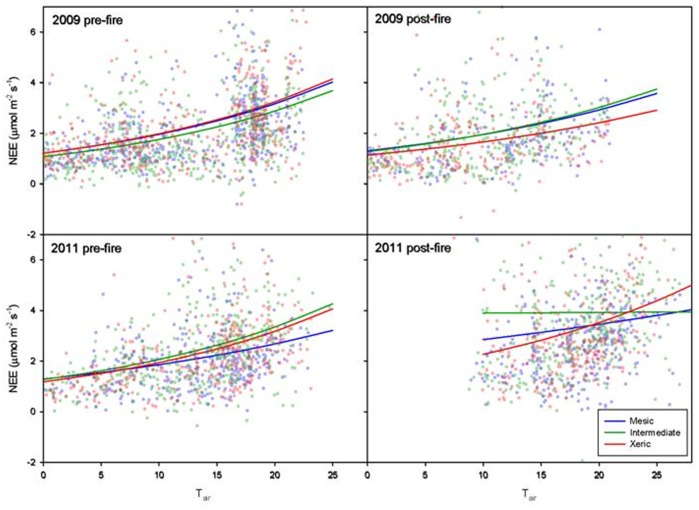
Representative pre- and post-fire temperature response curves.Representative nighttime temperature response curves pre- (left) and post-fire (right) in January 2009 (top) and March 2011 (bottom) at the xeric, intermediate and mesic sites (green, red and blue, respectively).